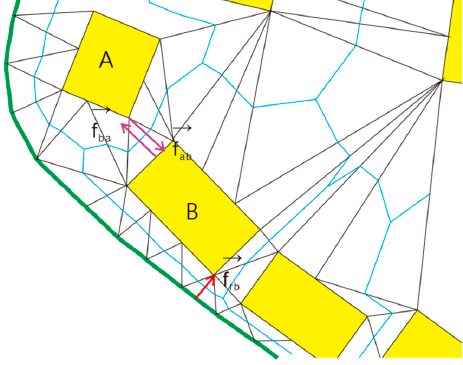
Figure 4. BB-conflict and BR-conflict.